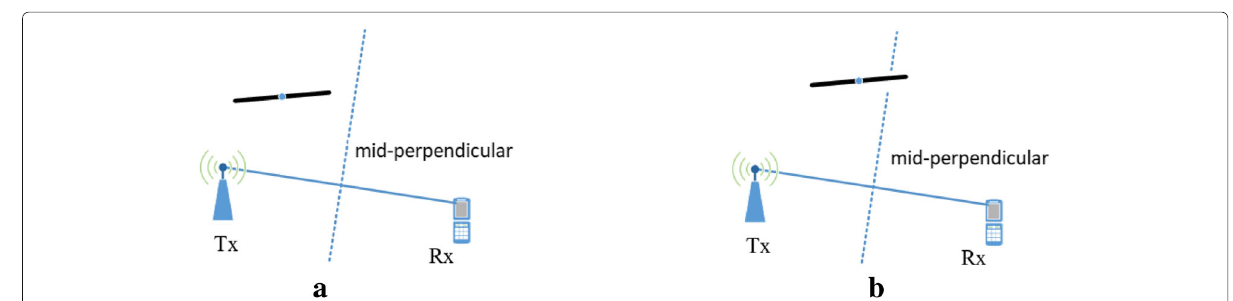
Fig. 5 Illustration of Event 3. In a , Event 1 and Event 2 hold true: The typical object acts as a reflector. In b , Event 1 holds true but Event 2 does not hold true: The typical object cannot be a